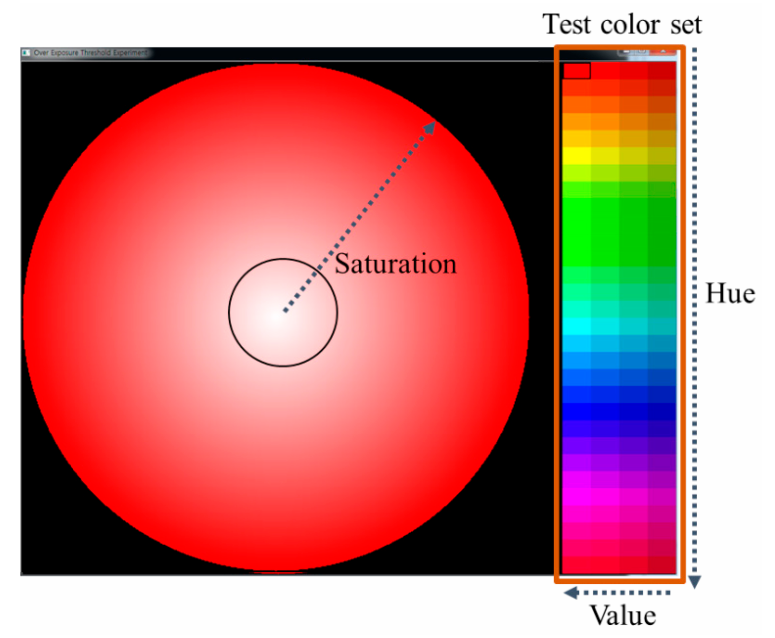
Figure 3. Test set for evaluating the saturation sensitivity of